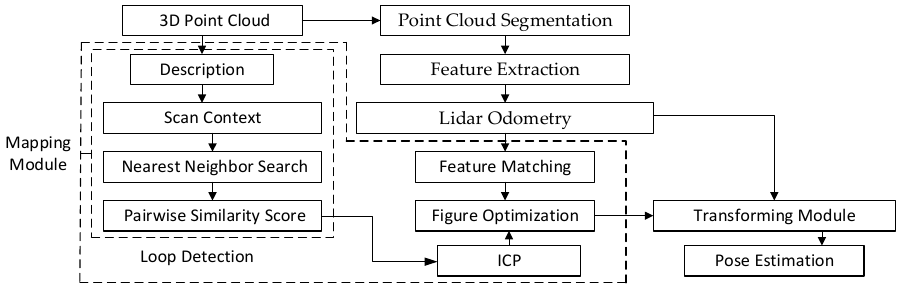
Figure 4. System structure diagram of the LeGO-LOAM-SC algorithm.